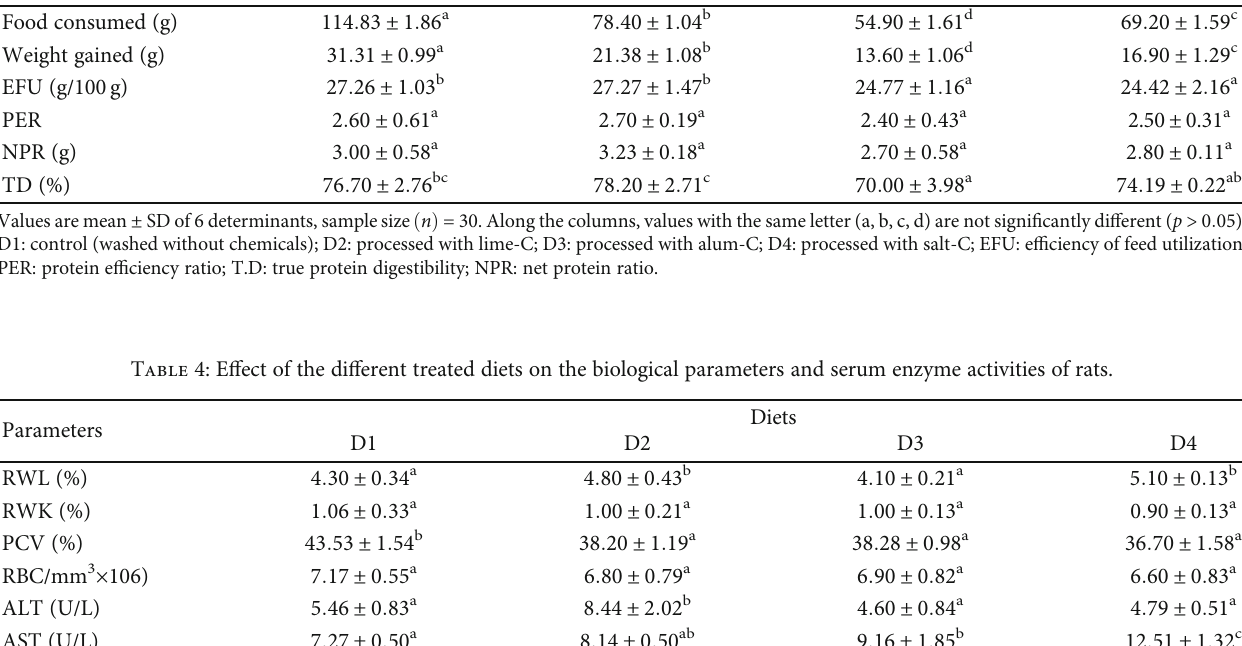
Table 3: E ff ects of di ff erent treated diets on the performance of rats and protein quality. Parameters